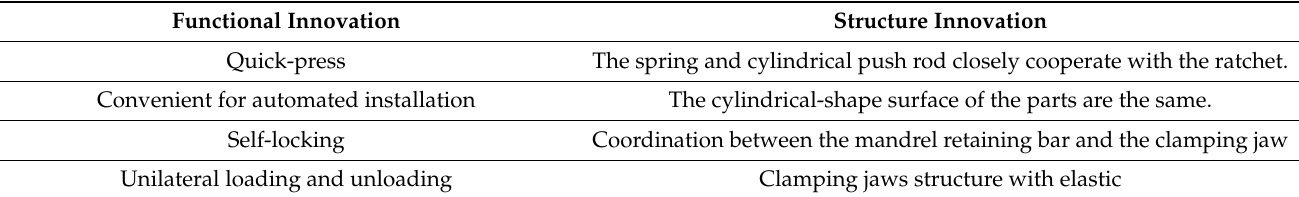
Table 1. Functions and corresponding innovative